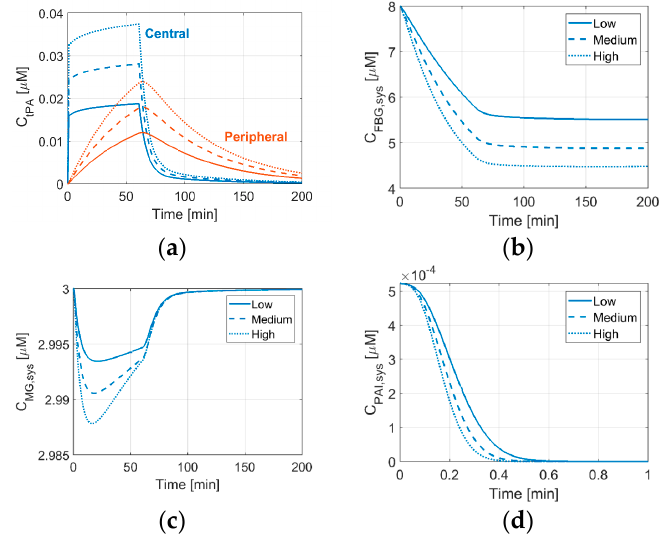
Figure 4. Changes in systemic concentrations of fibrinolytic proteins over time with different drug doses: 0.6 (Regimen 2), 0.9 (Regimen 1), and 1.2 (Regimen 3) mg/kg of patient weight, as low (solid line), medium (dashed line) and high (dotted line) doses, respectively. ( a ) tPA concentration in the central (blue lines) and peripheral (orange lines) compartments, ( b ) systemic concentrations of fibrinogen (FBG), ( c ) α 2 -macroglobulin (MG), and ( d ) plasminogen activator inhibitor type 1 (PAI) (shown for 1 min only).